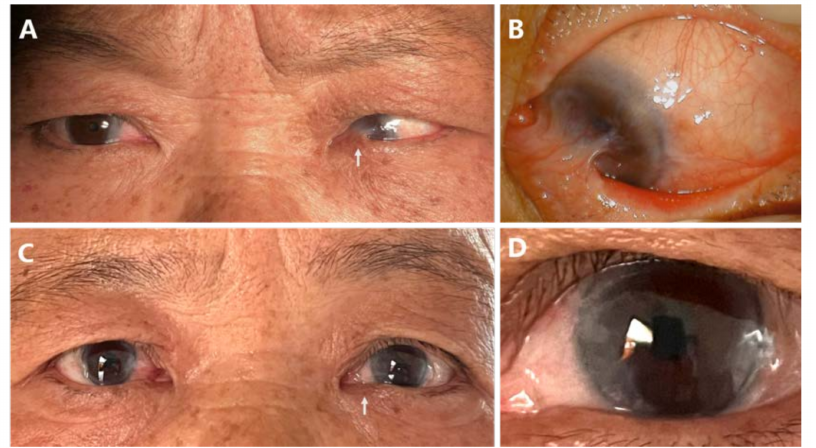
Figure 3. Case 4. A 60-year-old female underwent three prior pterygium surgeries with the sequela of serve symblepharon (white arrow) and total limitation of abduction ( A ). The scar tissue covered her central cornea ( B ). Thirty-one months after sandwich transplantation, she recovered orthotropic ( C ) with a smooth and stable ocular surface ( D